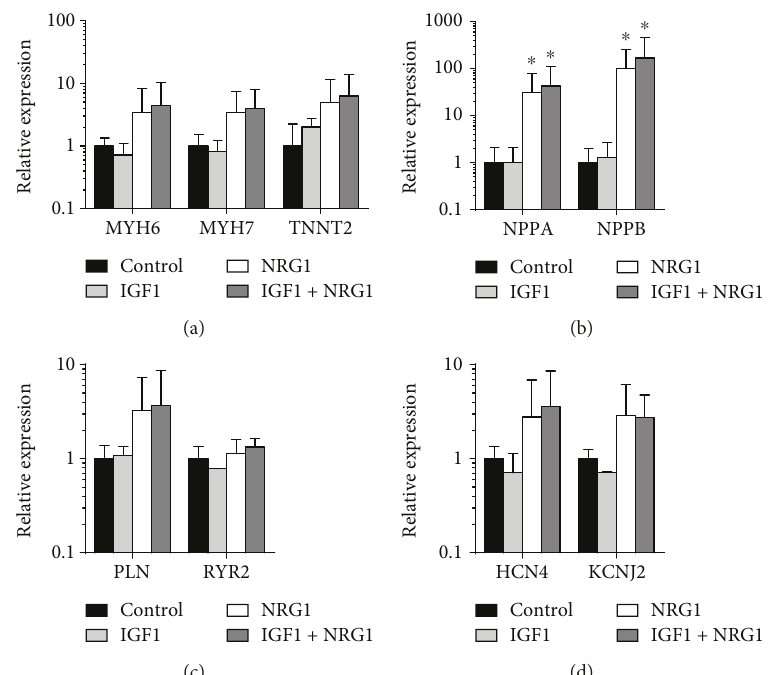
Figure 4: Engineered tissues alter their gene expression patterns by q-RT-PCR analysis in response to biochemical stimulation. Genes shown encode proteins associated with the contractile lattice (MYH6: α -myosin heavy chain, MYH7: β -myosin heavy chain, TNNT2: cardiac troponin T) (a), development (NPPA: atrial natriuretic peptide, BNNP: brain natriuretic peptide) (b), calcium handling (PLN: phospholamban, RYR2: ryanodine receptor 2) (c), and voltage-gated ion channels (HCN4: hyperpolarization-activated cyclic nucleotide- gated channel, KCNJ2: inward-recti fi er potassium ion channel) (d). n = 3 per group; data are shown as fold induction of gene expression normalized to HPRT1 and expressed as mean ± SEM. ∗ P < 0 05